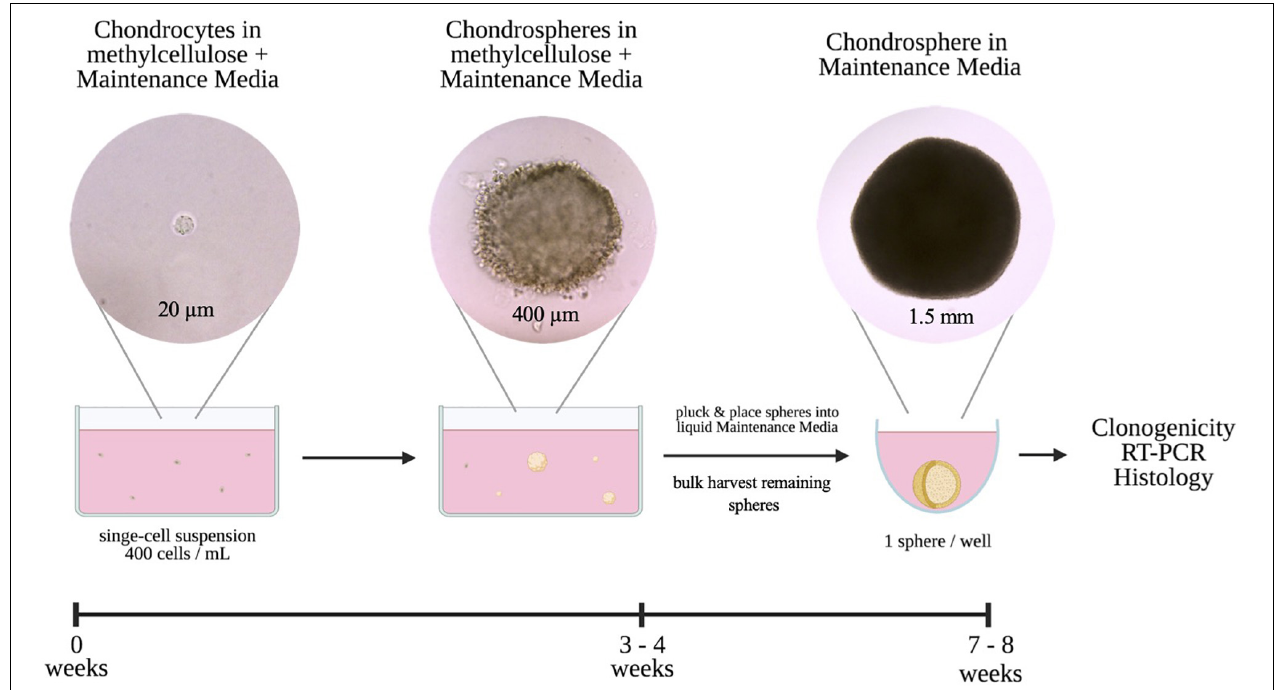
FIGURE 1 | Schematic and timeline of 3D single-cell based in vitro culture method of colony-forming chondrocytes.